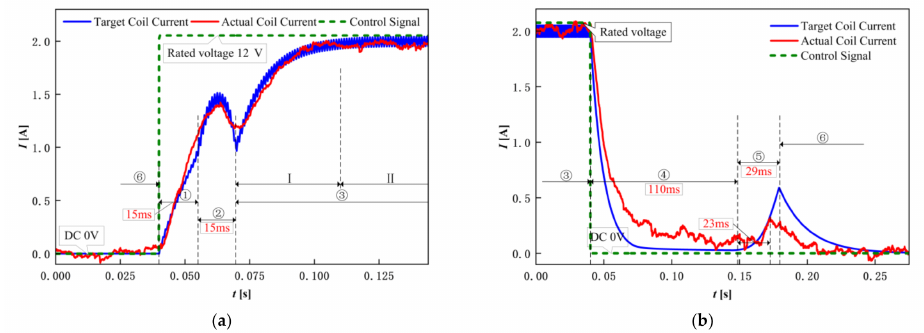
Figure 9. Correlation between the simulated and experimental results with a coil current of 12 V: ( a ) switching on; ( b ) switching